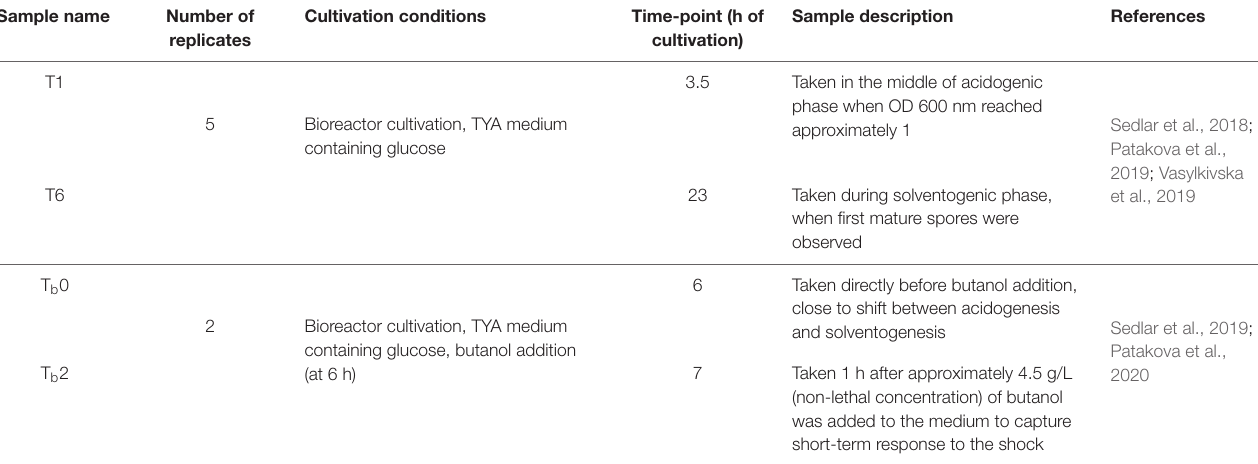
TABLE 1 | RNA-Seq